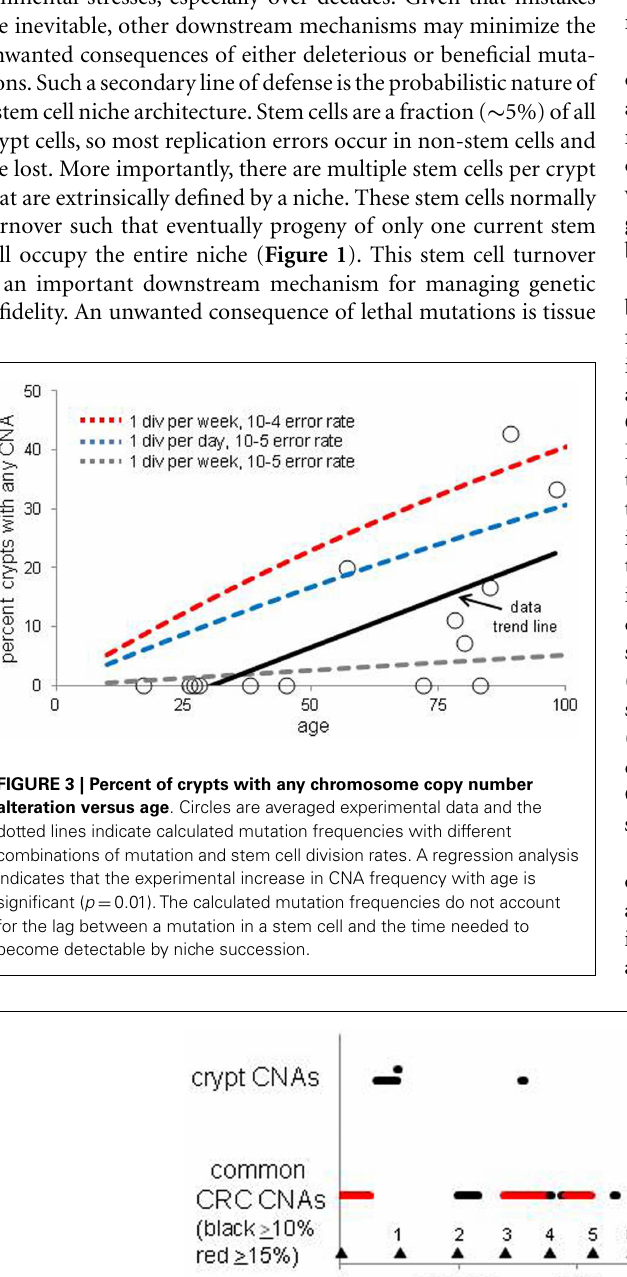
preferentially fall within common CRC CNA intervals, but appeared randomly scattered by chance (see Table 3 ).Triangles indicate chromosome